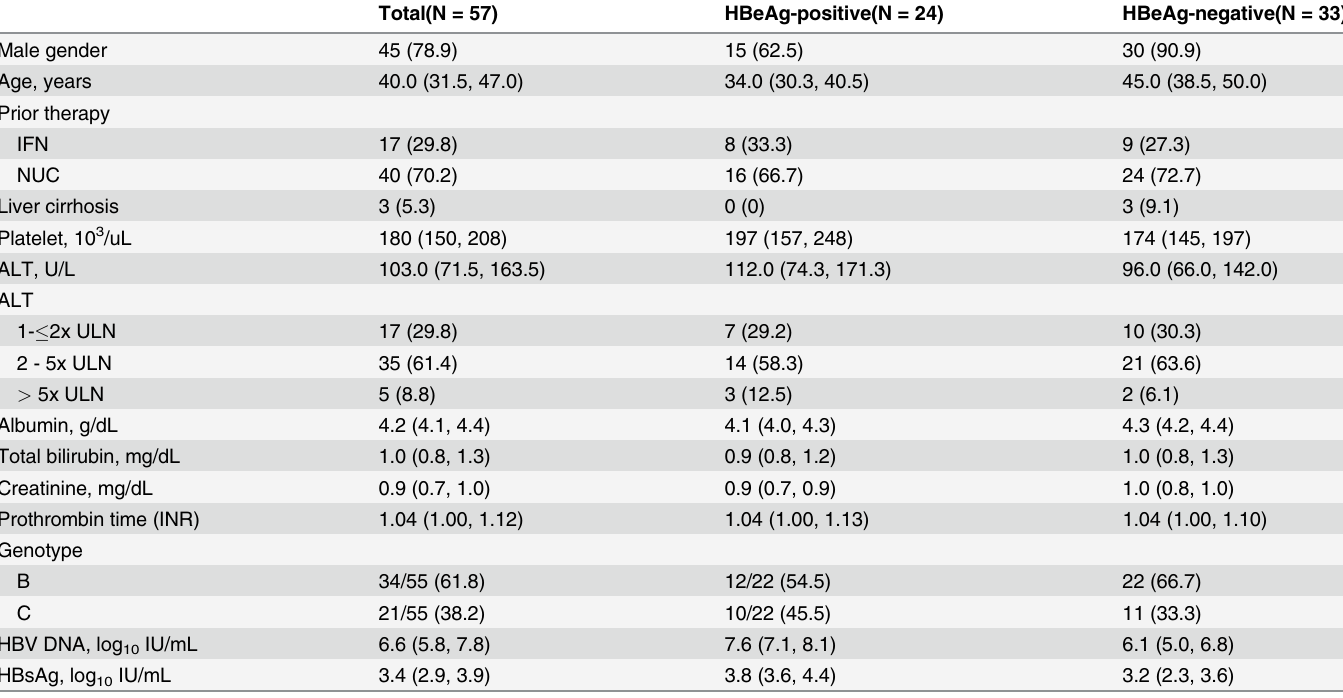
Table 1. Demographic data and baseline characteristics of all treatment-experienced CHB patients. Total(N =